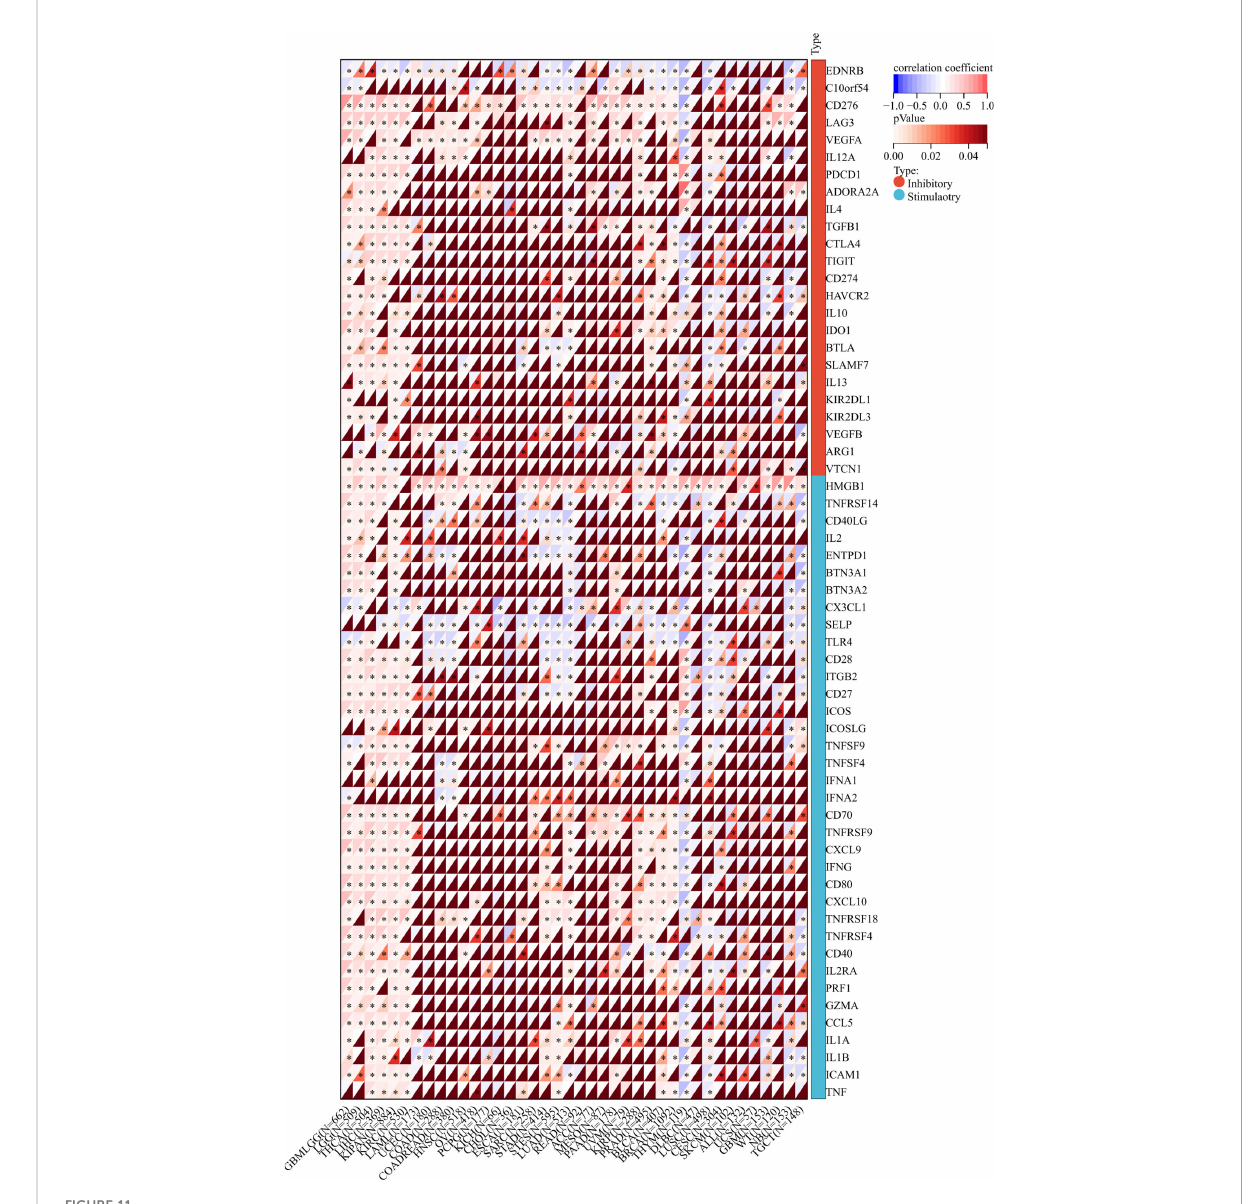
FIGURE 11 The relationship between TROAP expression and immune regulatory gene markers in pan-cancer. All *:P <